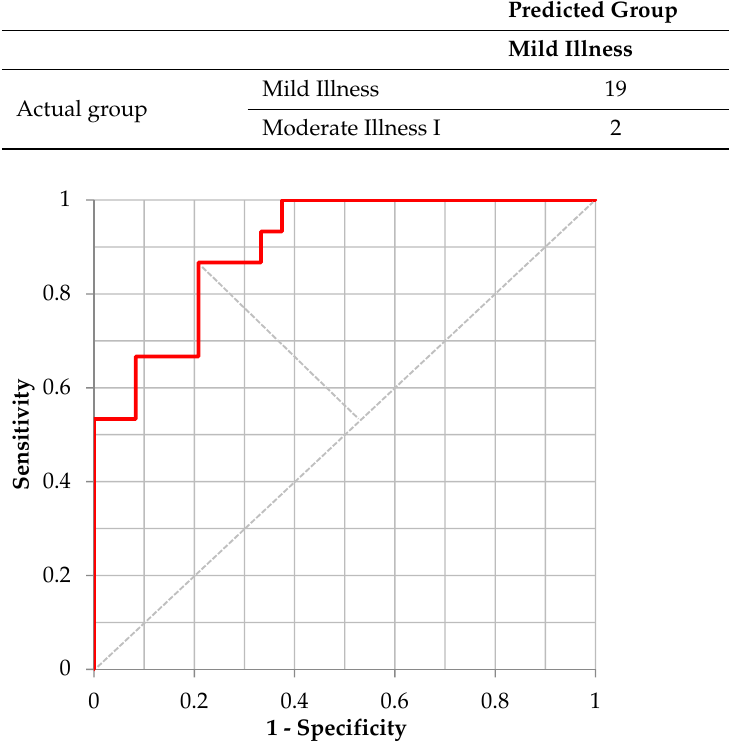
Figure 3. ROC curve distinguishing “Moderate Illness 1” using the learning model of /Uh/. Table 12. Confusion matrix of /Ah/, /Eh/, and /Uh/.